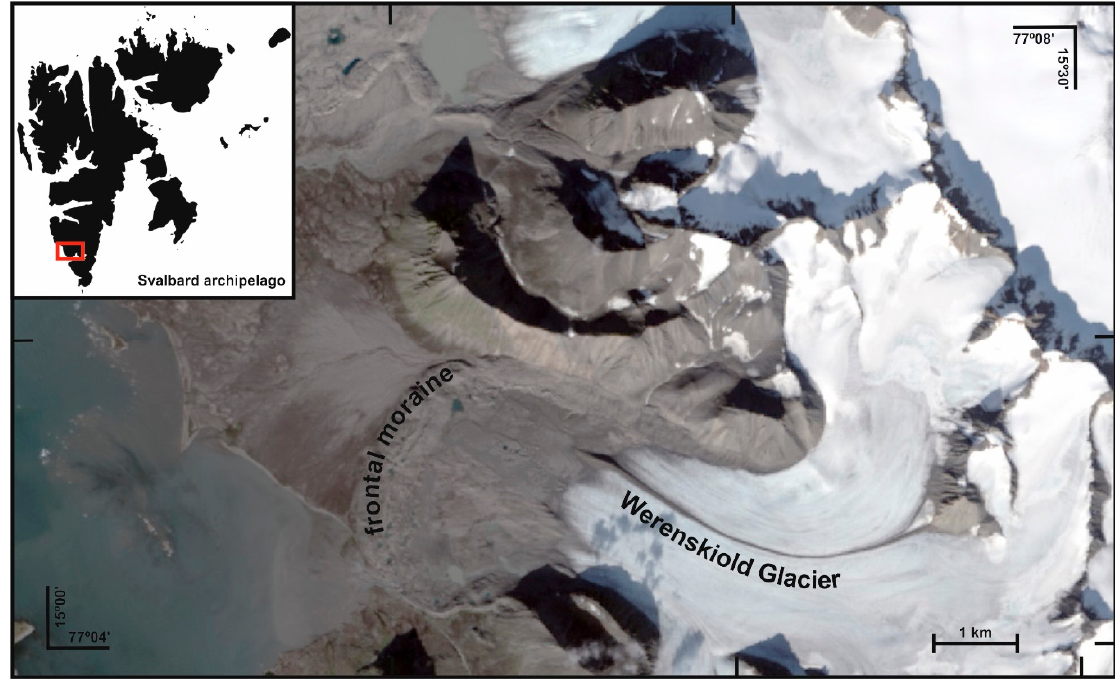
Figure 1. Location of the area of interest: end moraine of the Werenskiold Glacier, SW Spitsbergen (based on [46]).